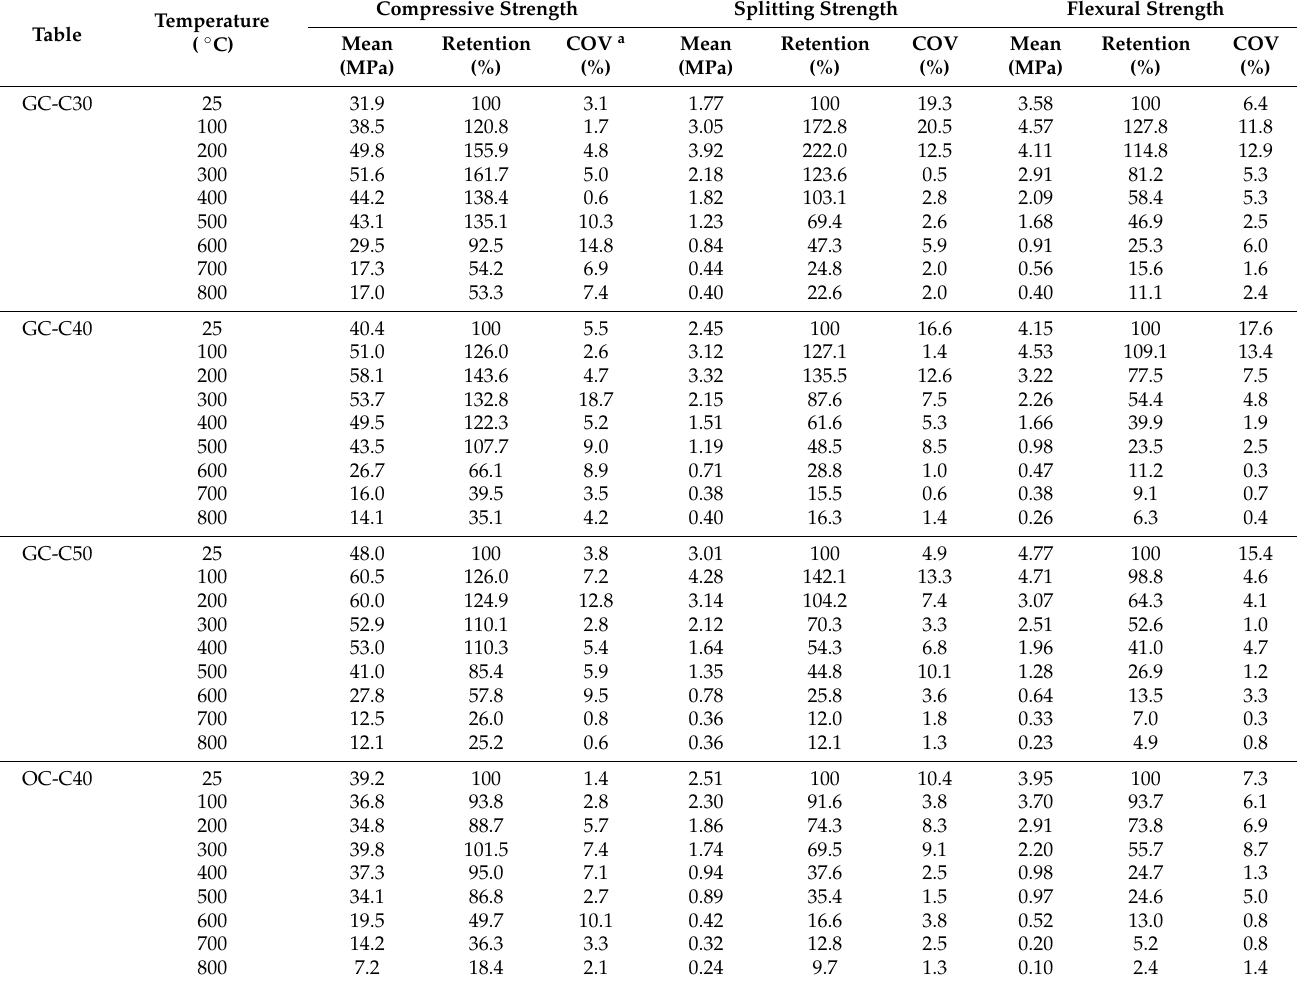
Figure 9. Residual flexural strength of concrete after exposure to elevated temperature: ( a ) flexural strength and ( b ) retention. Table 4. Tested compressive, splitting and flexural strength of concrete